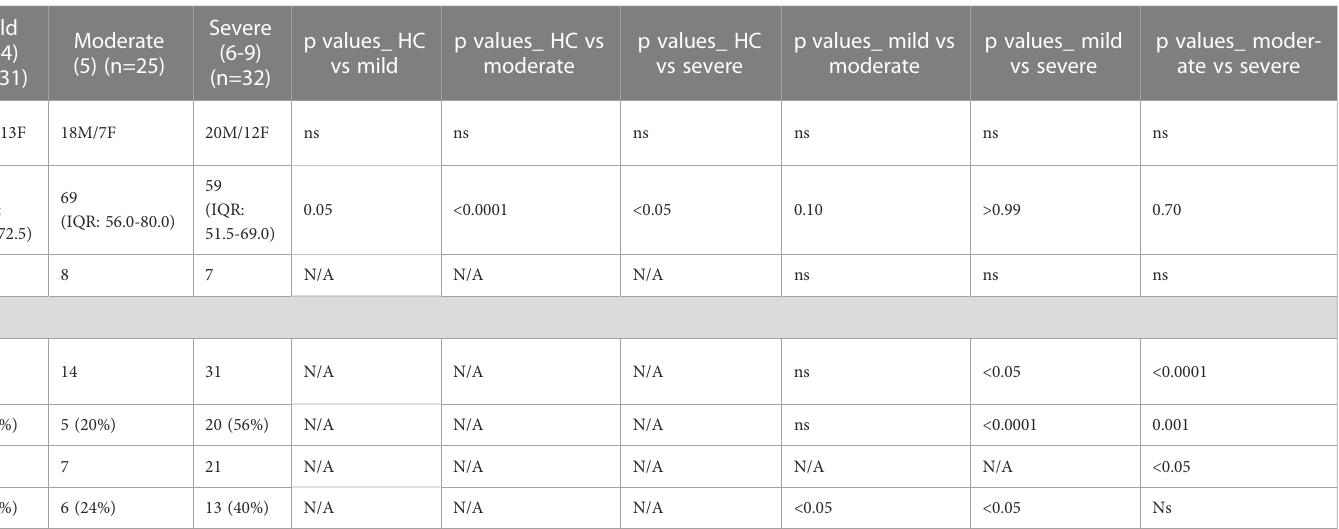
TABLE 1 Demographics and clinical characteristics of